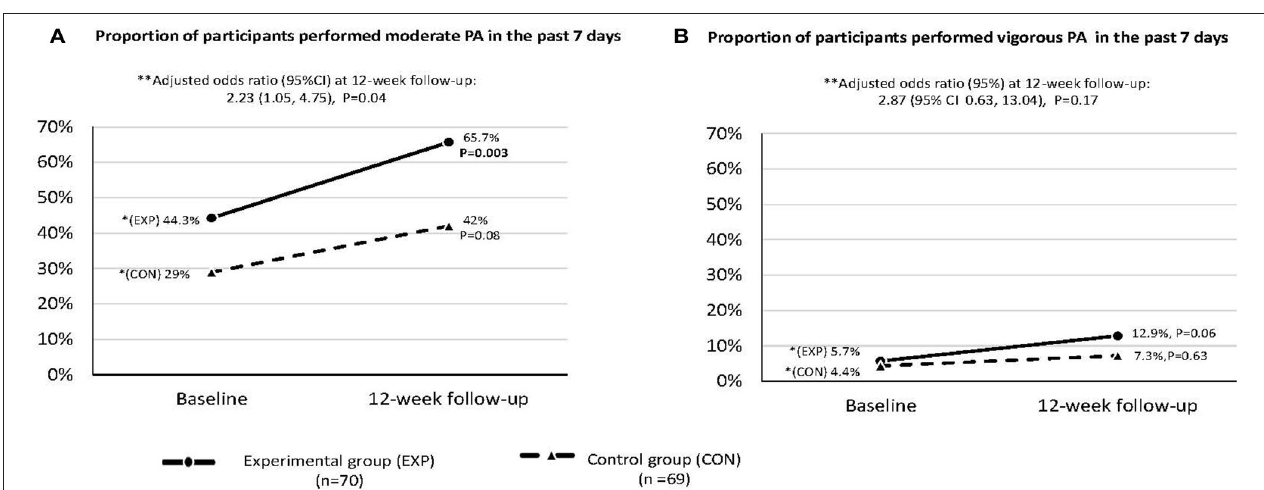
FIGURE 3 | The proportion of participants who performed moderate and vigorous physical activities in the past 7 days at baseline and 12-week follow-up: Intention-to-treat analysis ( n = 139). This was measured by the short form of International Physical Activity Questionnaire—Chinese version. *Within-group comparison was done by McNemar test. **Between-group comparison by logistic regression with adjustment of age, sex and baseline values.